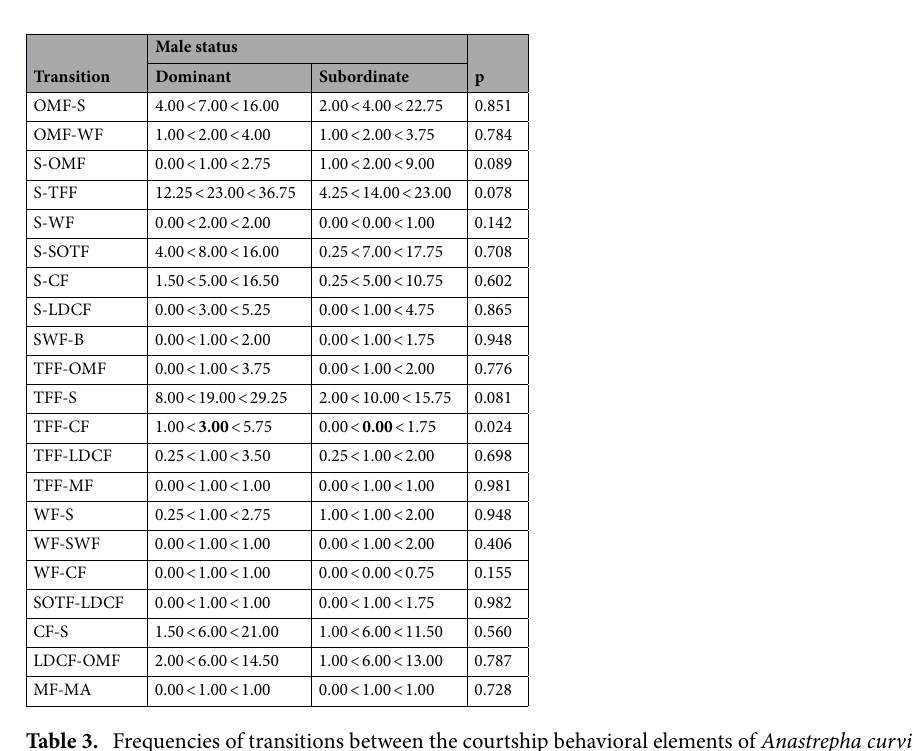
Table 3. Frequencies of transitions between the courtship behavioral elements of Anastrepha curvicauda dominant and subordinate (7–8 days old) males caged with a virgin 5–7 days old female. Non-choice experiment. Reported values are Q1 < Median < Q3 (n = 15). Medians in bold in the same row are significant different (Mann–Whitney test, p > 0.05). See Table 1 for